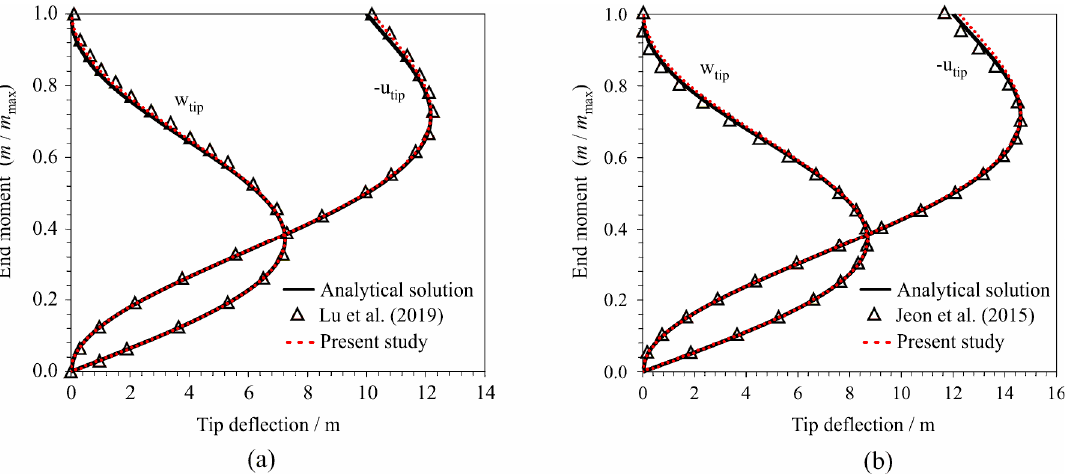
Figure 14. Load–displacement curves for the cantilever plate exposed to end moment for the lengths ( a ) L = 10 m and ( b ) L = 12 m.